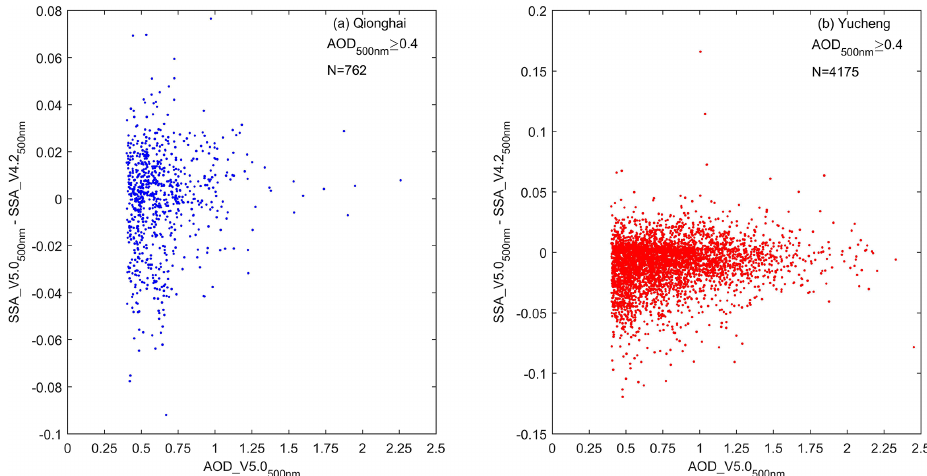
Figure 10. Scattergrams of the difference between SSAs at 500nm retrieved by V5.0 and V4.2 (defined as SSA_V5.0–SSA_V4.2) and the corresponding AODs at 500nm by V5.0 during February 2013 to December